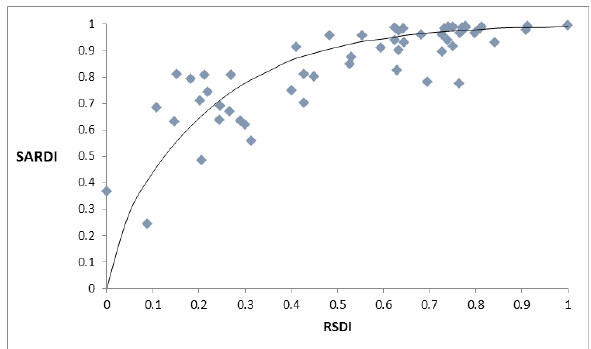
Figure 8. Correlation analysis between the SAR seismic damage index SARDI and the optical remote sensing seismic damage index RSDI.